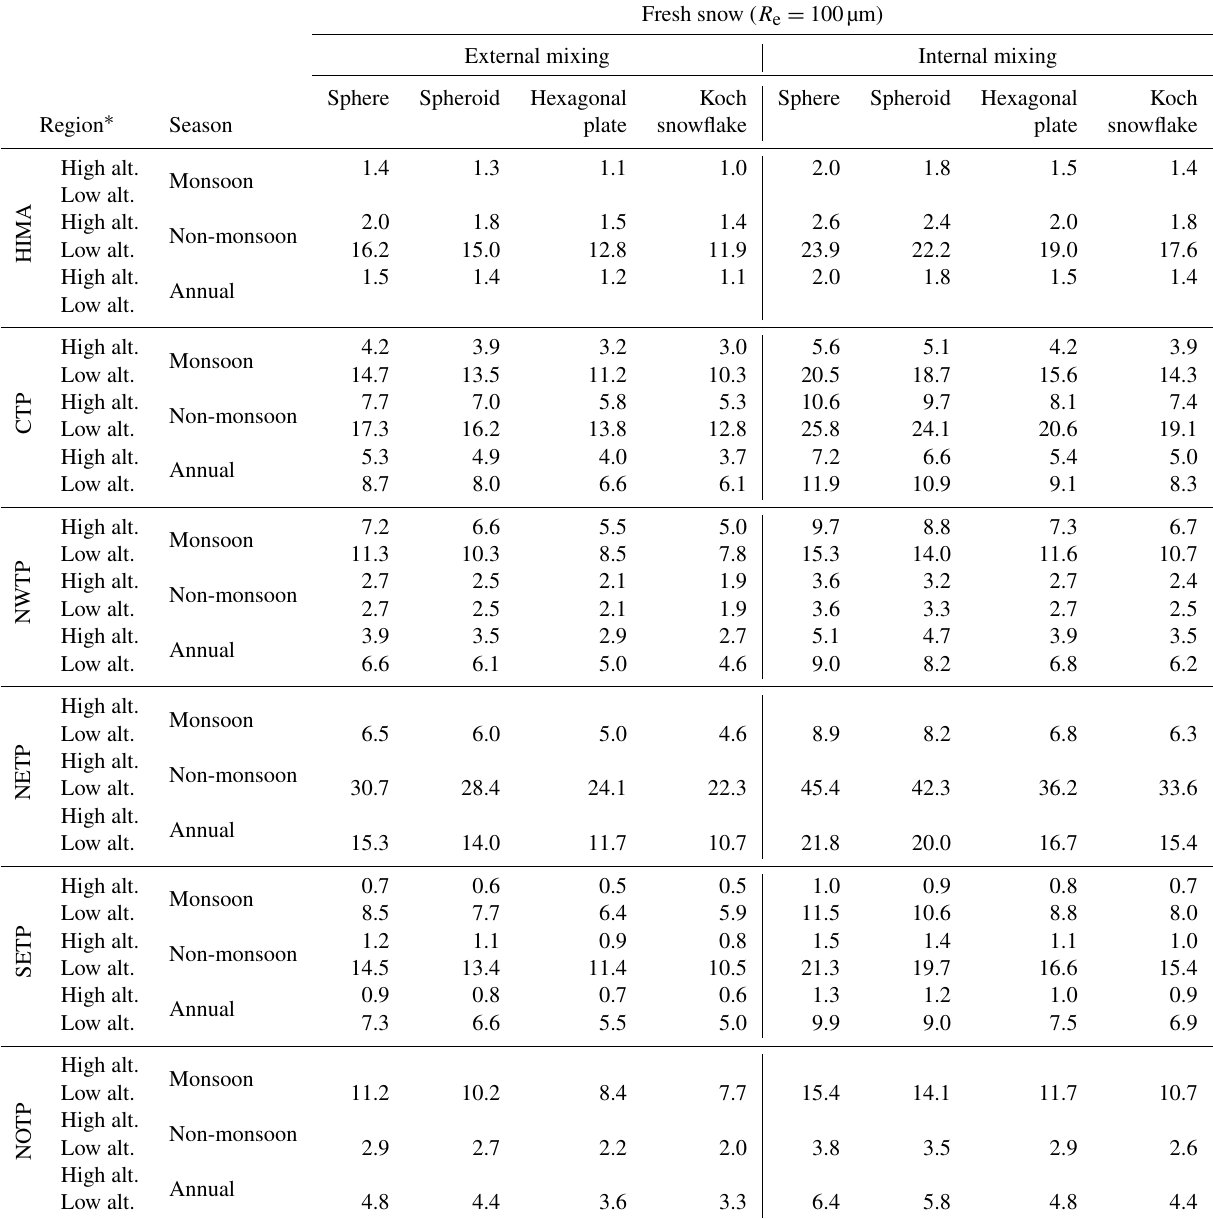
Table 3. Regional and seasonal mean BC-induced all-sky surface radiative effects (Wm − 2 ) for fresh snow over the Tibetan Plateau during 2000–2015. See Table S4 in the Supplement for results of aged snow.